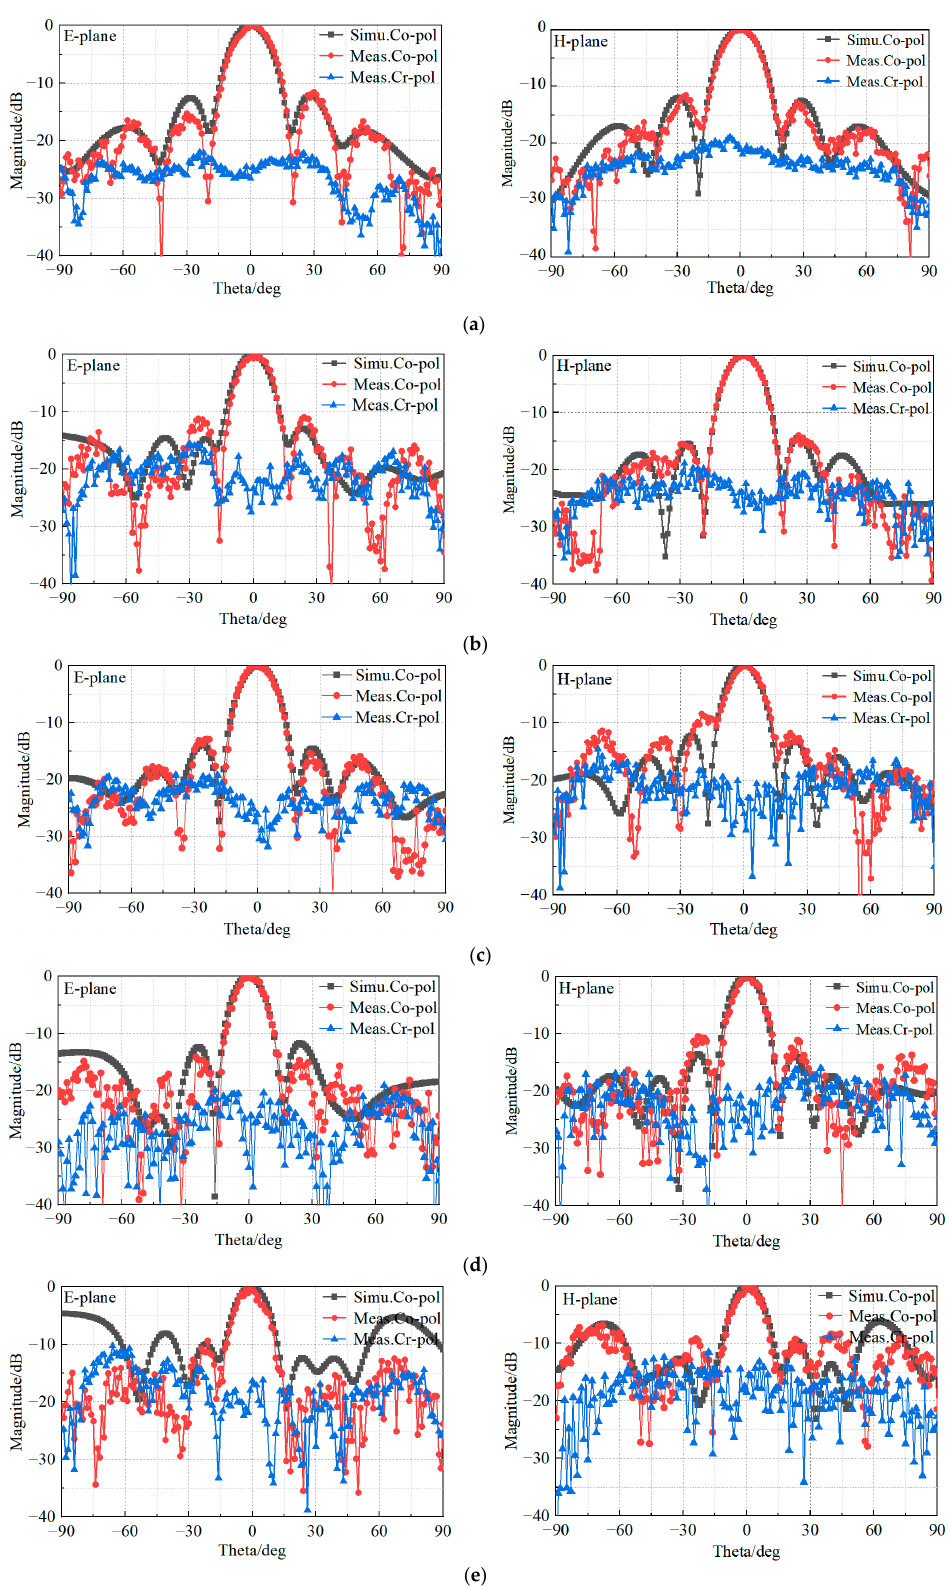
Figure 14. Comparison between simulated and measured re fl ection coe ffi cient magnitude.